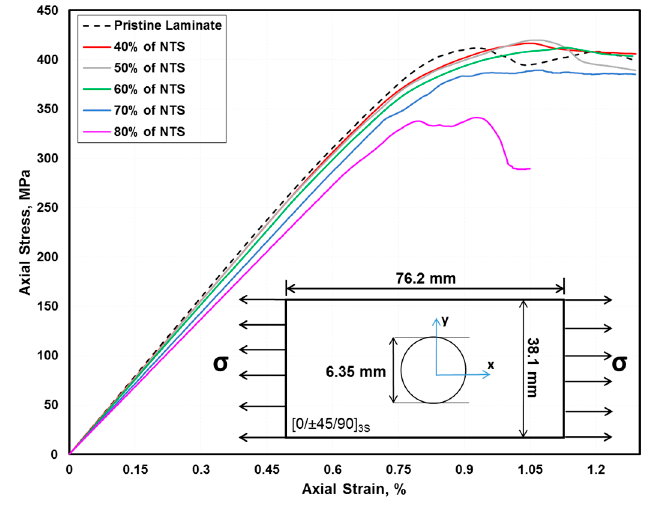
Figure 9. Stress-strain response of the quasi-isotopic OHT specimen in pristine state and post-fatigue tested state after 10 6 fatigue load cycles ( R = 0.1) at different specified maximum stress levels. Table 5. Comparison of the residual strength of the Open Hole Tension (OHT) specimen with test data [34]. Fatigue Loading Maximum Stress Level for